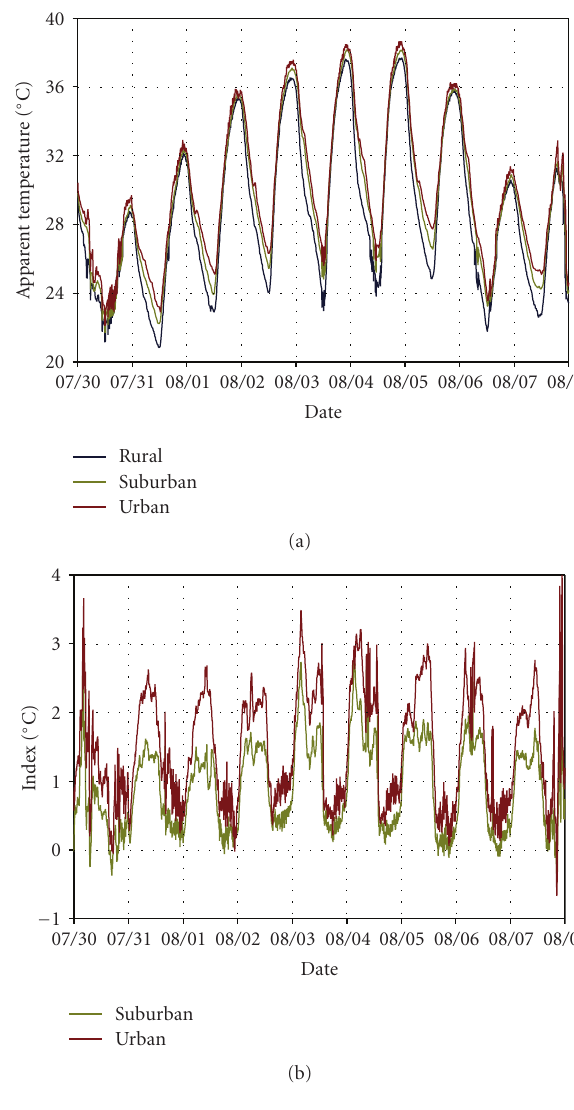
Figure 7: (a) Composite urban (red), suburban (gold), and rural (blue) values of relative apparent temperature (M07) from 30 July 2008 to 8 August 2008. (b) Composite diurnal values of relative apparent temperature (M07) with respect to rural composite values for the urban (red) and suburban (gold)